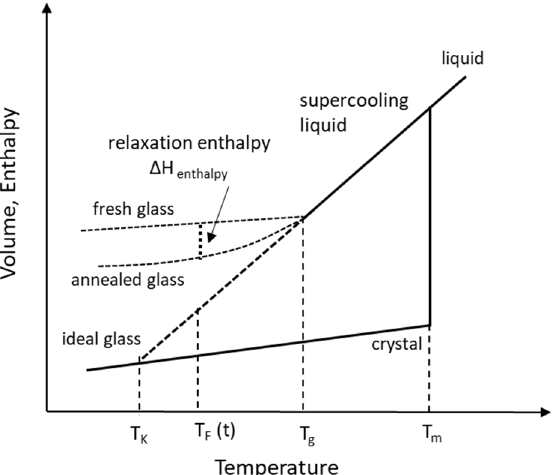
Figure 4. Phase diagram of liquid-crystal and liquid-glass. (Temperatures—T K —Kauzmann, T g —glass transition, T F —fictive, T m —melting).